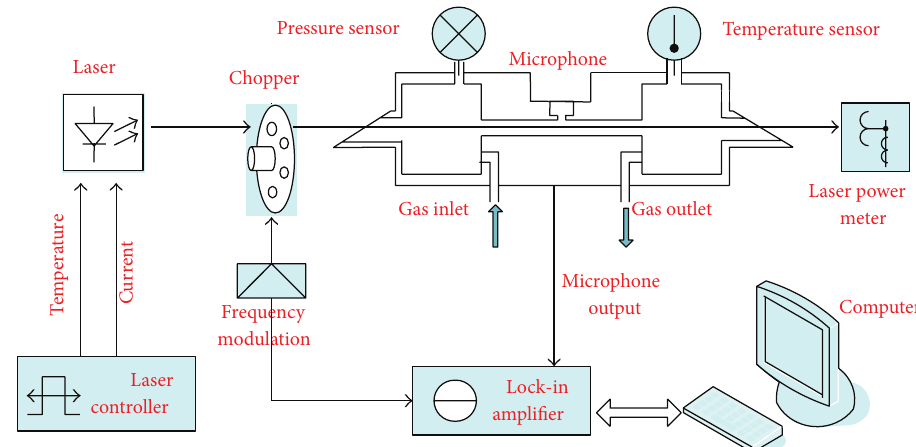
Figure 2: The structure diagram of the gas PAS detection system.